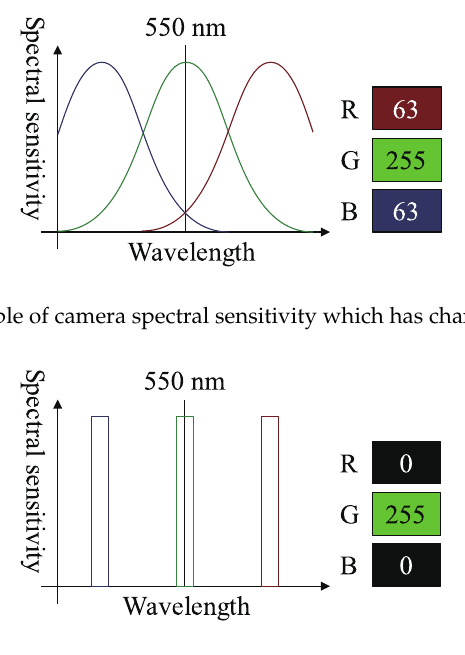
Figure 6. Example of camera spectral sensitivity which does not have channel